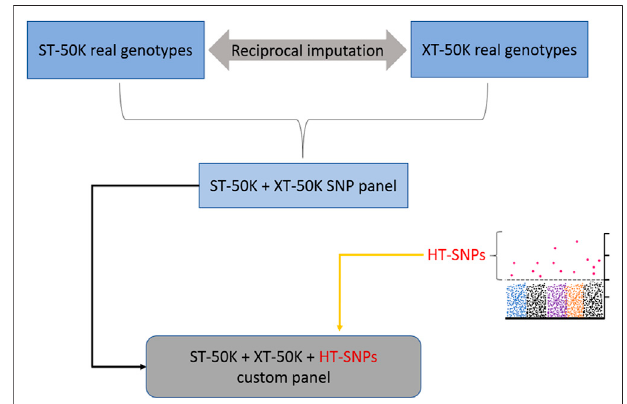
FIGURE 9 | Incorporating a pre-selected “ re fi ned ” set of heat-tolerance SNPs (HT-SNPs) into the combined set of real genotypes from standard- industry 50 k (ST-50K) and XT-50K SNP panel developed recently by Xiang et al.